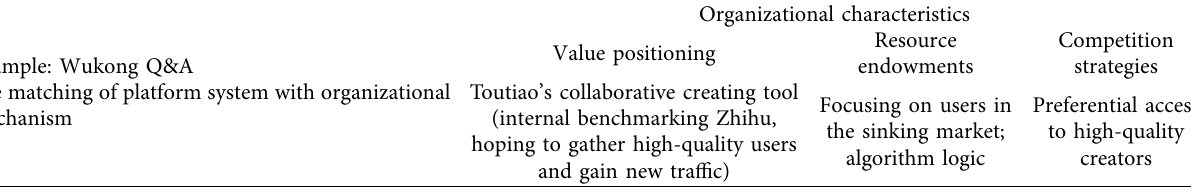
Table 2: The matching analysis diagram of platform systems with organizational